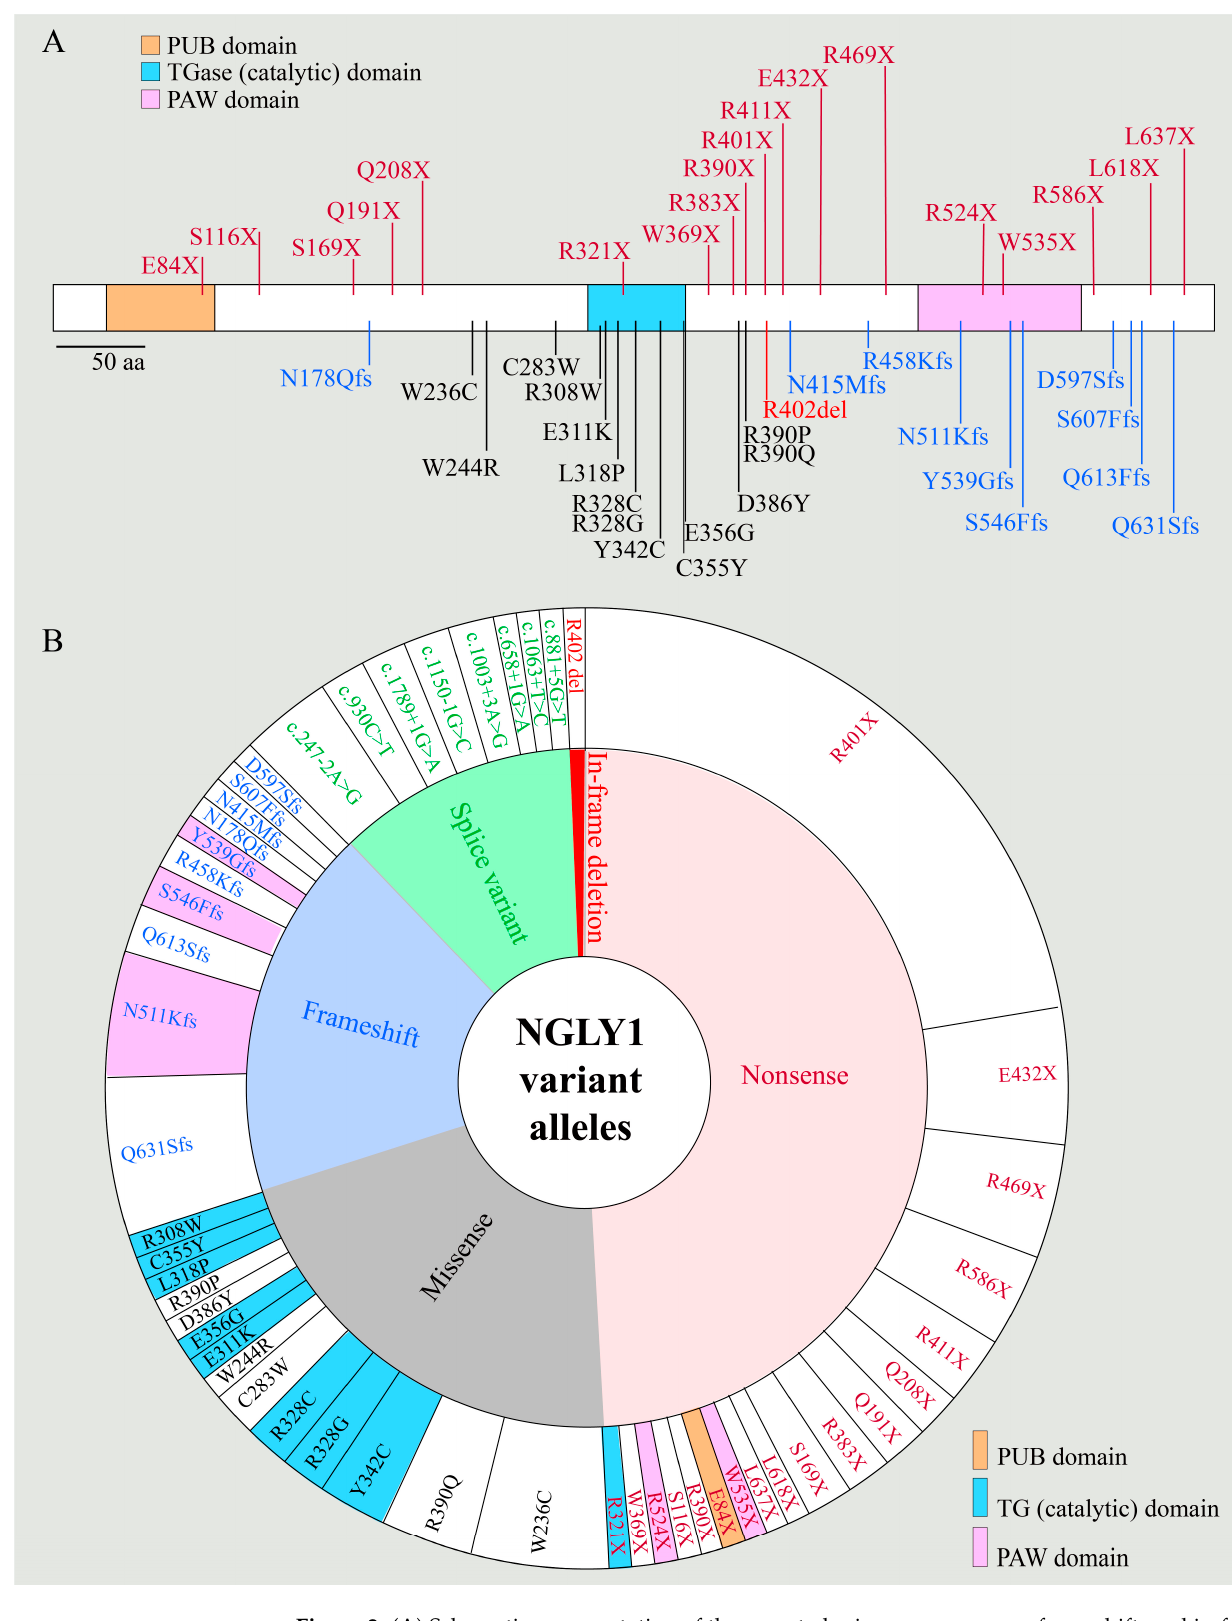
Figure 2. ( A ) Schematic representation of the reported missense, nonsense, frameshift, and in-frame deletion variants in NGLY1 . Nonsense variants are in maroon font above the NGLY1 schematic. Missense (black font), frameshift (blue font), and in-frame deletion (red font) are shown